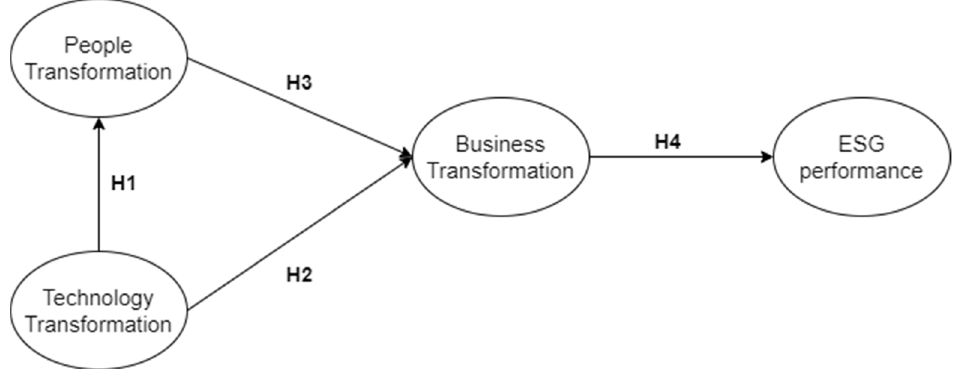
Figure 1. The research hypothesis development.